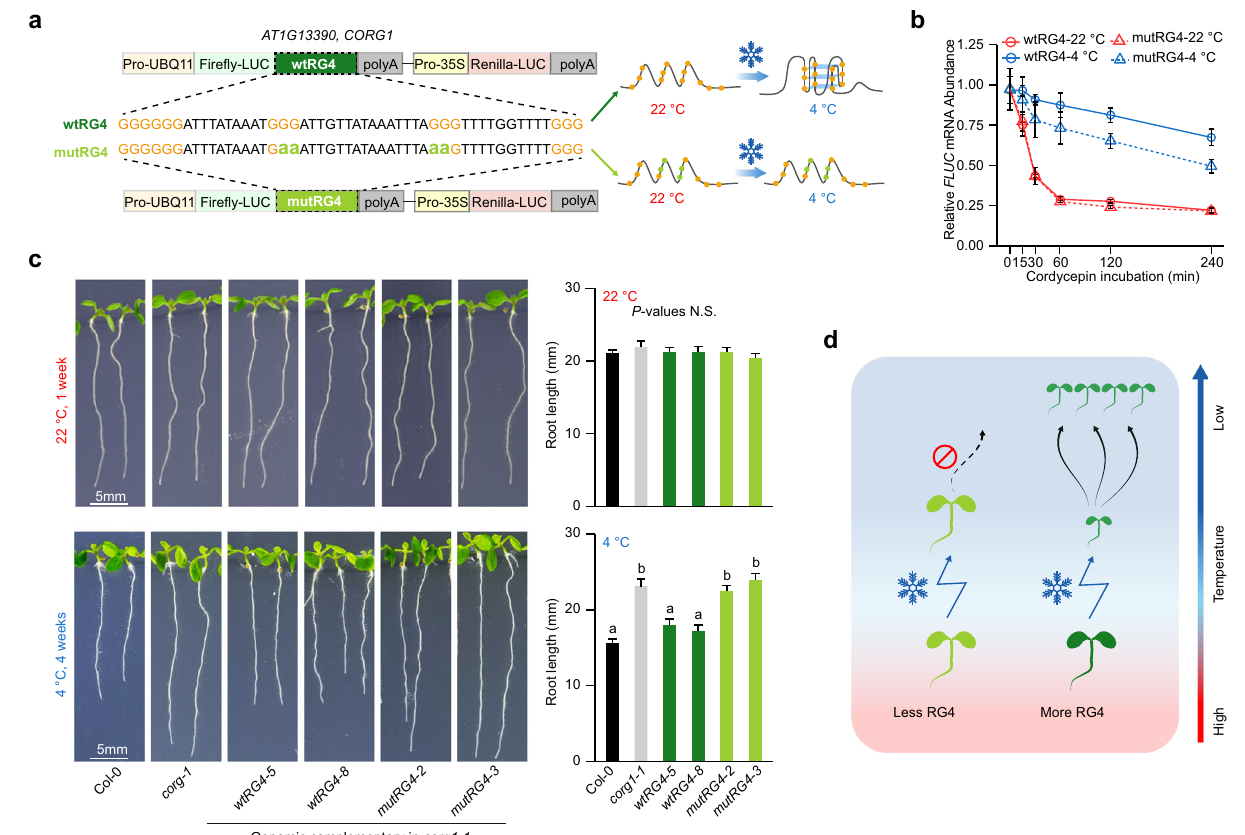
Fig.4 |RNAG-quadruplexregulatesplantcold-responsivegrowth.a Schematic of folding status of wild-type RG4 (wtRG4) and mutated RG4 (mutRG4) on CORG1 3 ′ -UTRat22°Cand4°C.TheRG4foldingpotentialwaseithermaintainedinwtRG4 or attenuated in mutRG4 by G to A substitution. b RNA decay curves at 22°C and 4°Cfor FIREFLY-LUCIFERASE ( FLUC )transcriptswithwtRG4ormutRG4,aswiththe designs shown in a . Data are presented as mean values±SE, n =4. c Phenotypes of plants of different genotypes grown at 22°C or 4°C. wtRG4 or mutRG4 denotes corg1-1 mutant complemented with genomic DNA of CORG1 carrying wtRG4 or